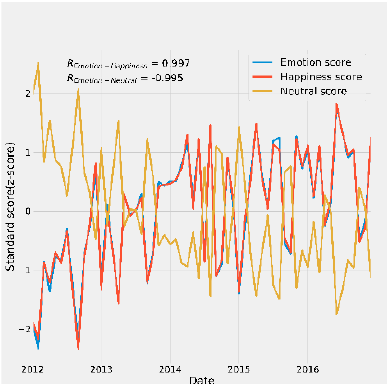
Based on the coefficients of X i in Eq.3’, we can infer that happiness and neutral are two dominant key emotions of the final emotion score. Note that happiness has negative influence on the emotion score while neutral has positive influence. As this, seems to contradict our common sense, we redefined the emotion score as its negative, that is: where E sn is the new and final emotion score used in the later analysis. Correlation coefficient between the emotion score and happiness was calculated and visualized in order to illustrate the relationship of the two.